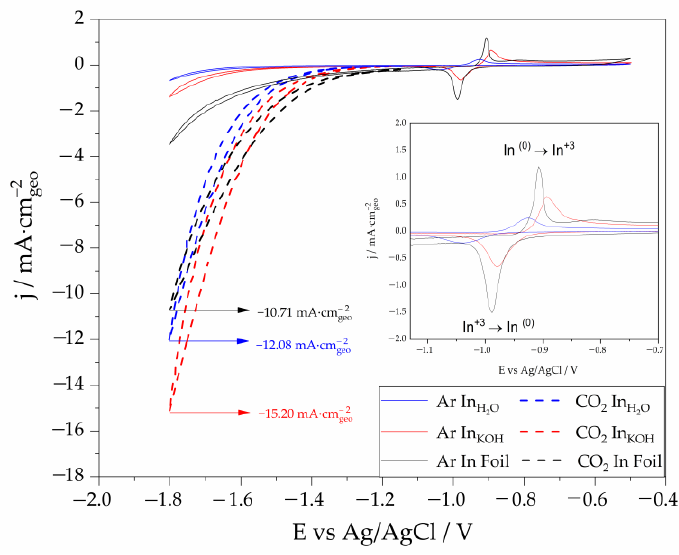
Figure 5. Cyclic voltammograms obtained in Ar (solid lines) and CO 2 (dashed lines) saturated solutions (KHCO 3 0.5 M + KCl 0.45 M) for In H2O , In KOH and In foil electrodes. Scan rate 50 mV·s −1 .